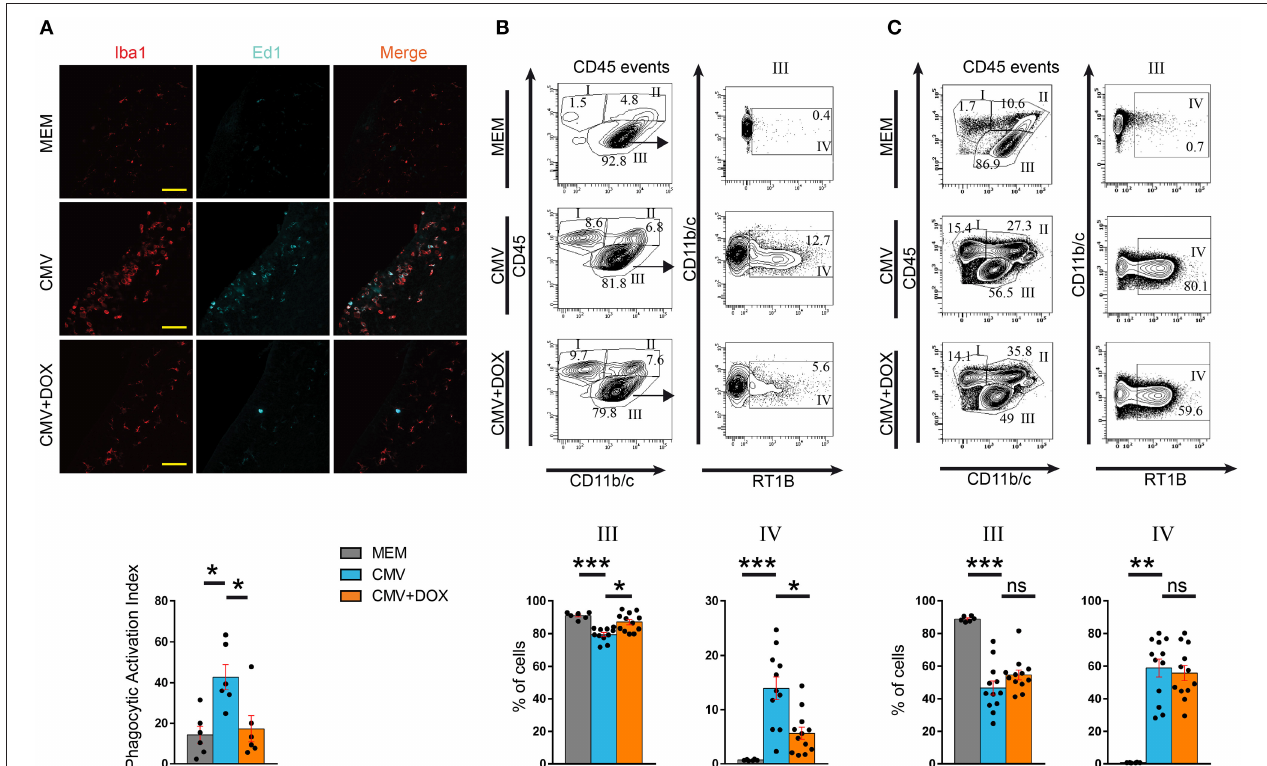
FIGURE 4 | CMV infection of the embryonic rat brain leads to altered microglia phenotype, which is rescued by maternal feeding with doxycycline throughout pregnancy. (A) Microglia status in the lateral ventricles was assessed on coronal sections observed by confocal microscopy at P1 by quantifying microglial cells (red, Iba1 + ) and phagocytically active microglial cells (Iba1 + , red; Cd68/Ed1 + , cyan). Those values were then used to calculate the phagocytic activation index (PAI) defined as the ratio of the number of Iba1 + , Ed1 + activated cells to the total number of Iba1 + cells. PAI increased in the CMV vs. the MEM group. Doxycycline (CMV + DOX) significantly counteracted PAI increase ( n = 6 brains in each condition). ROI: region of interest (387 × 200 µ m 2 ). Bar: 50 µ m. Kruskall-Wallis test followed by Dunn’s post-hoc test. * p < 0.05. (B,C) Flow cytometry analysis of leukocytes collected at P1 (B) and P7 (C) . Total leukocytes (CD45 events) were gated for CD45 and Cd11b/c, thus defining fractions I (lymphocytic cells), II (myelo-monocytic cells) and III (resident microglial cells) (see also Supplementary Figure 3). Fraction III corresponding to CD45 low / int , CD11b/c + microglial cells was further characterized for RT1B expression to identify reactive microglia (RT1B + ; fraction